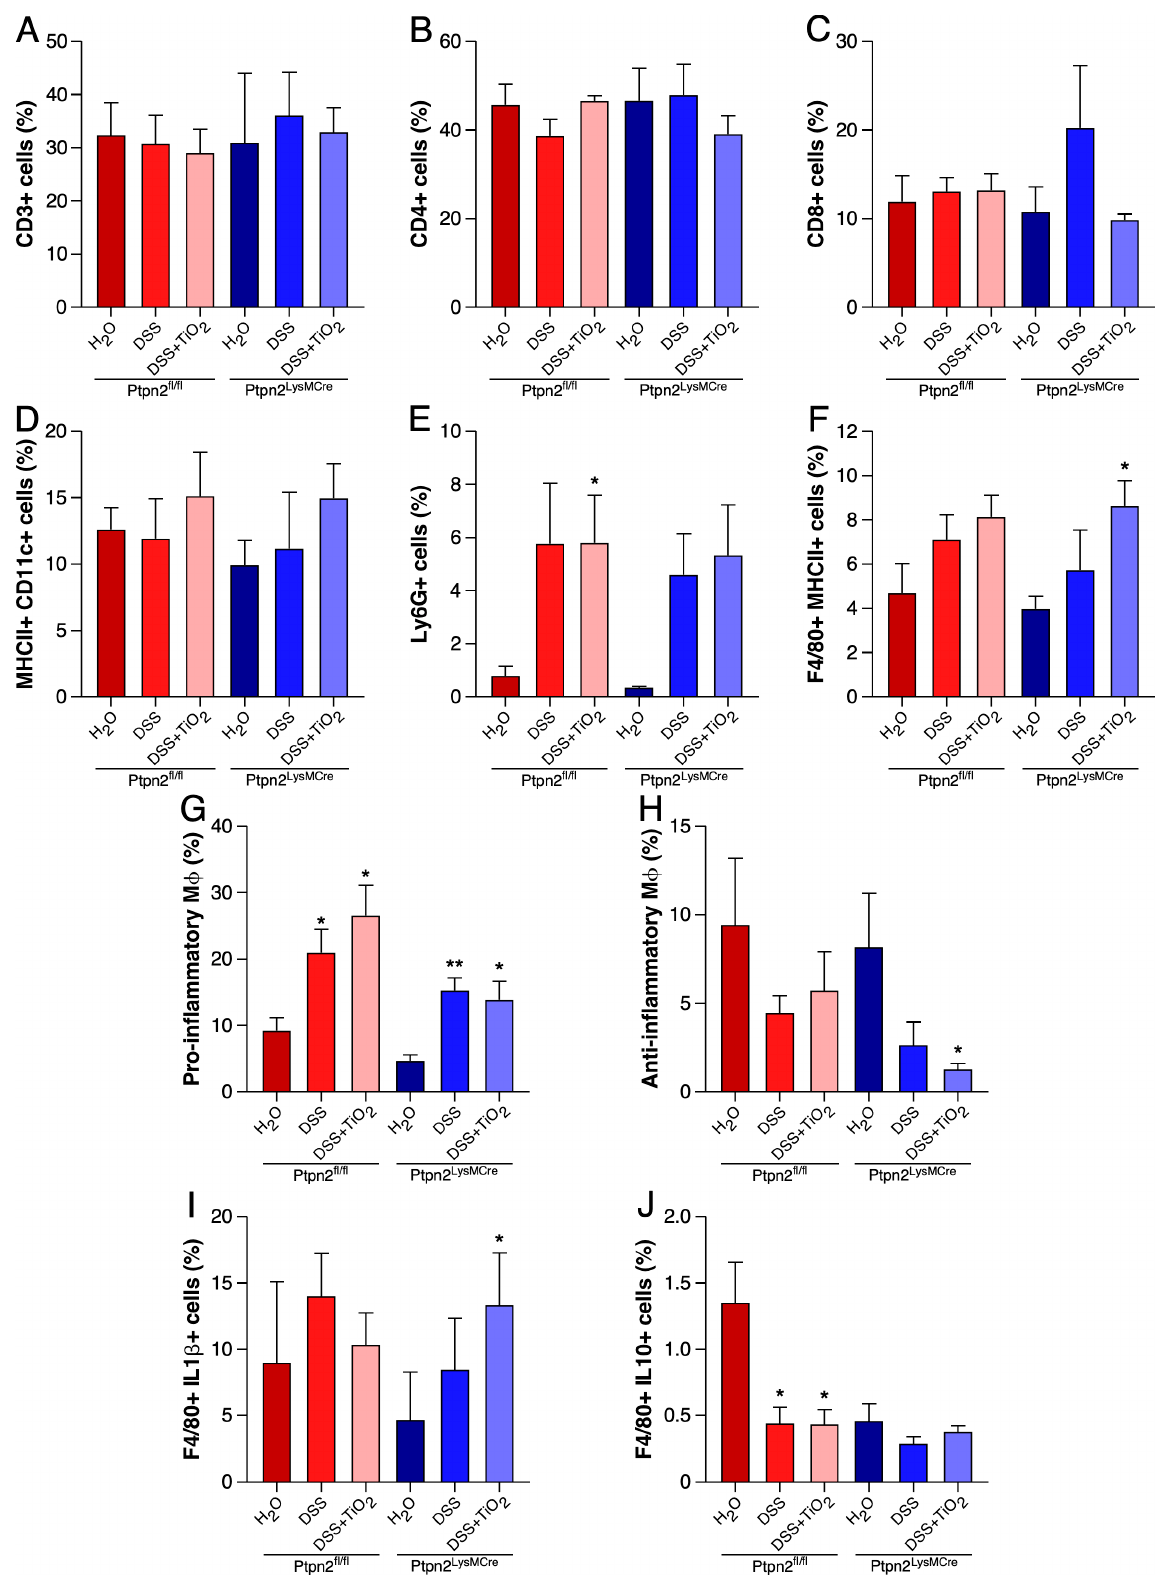
Figure 4. TiO 2 down-regulates the frequencies of anti-inflammatory macrophage in LPLs. ( A ) CD3+ T cells detected by flow cytometry analysis in LPLs from Ptpn2 fl/fl and Ptpn2 LysMCre mice during DSS-acute colitis under the indicated treatments. ( B ) Frequencies of CD4+ T cells detected by flow cytometry analysis in LPLs from Ptpn2 fl/fl and Ptpn2 LysMCre mice during DSS-acute colitis under the indicated treatments. ( C ) Frequencies of CD8+ T cells detected by flow cytometry analysis in